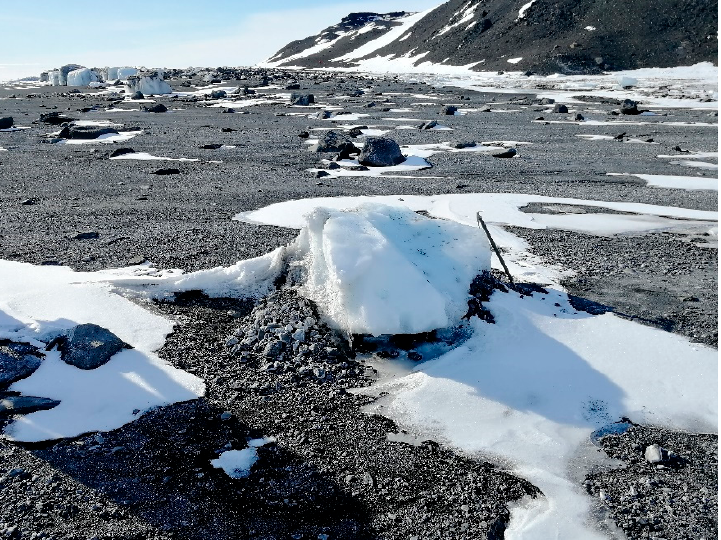
Figure 10. Example of coarser sediment (seaward) and finer sediment (inland) of a SIB that ploughed the substrate.